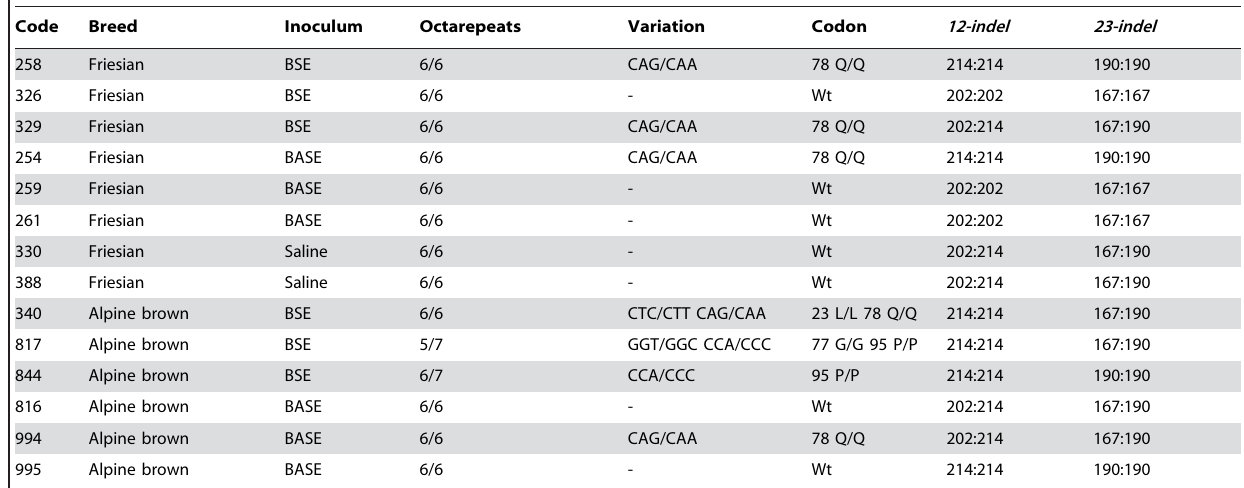
doi:10.1371/journal.ppat.1000075.t001 involvement of central grey matter (periaqueductal grey) and rostral colliculus but not the vestibular nuclear complex were observed in BASE-inoculated cattle as compared to BSE- challenged animals, which showed severe involvement of the putamen (Figure S1). Additional brain areas, including the olfactory areas, amygdalae, hippocampi and dorsal horns of spinal cords, were severely involved in both groups. Ventral and dorsal roots did not show major pathological changes.